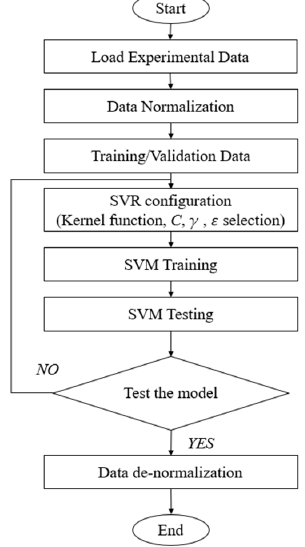
Figure 4. Flowchart of SVR model [50].